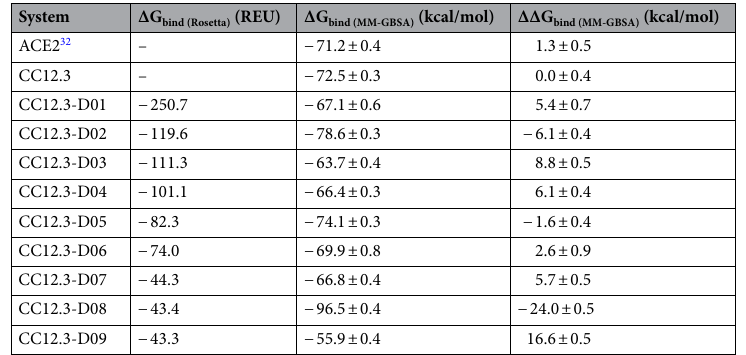
Table 2. The binding free energies of Fab CC12.3 and designed Fabs CC12.3 binding to SARS-CoV-2-RBD, as calculated by Rosetta and MM-GBSA